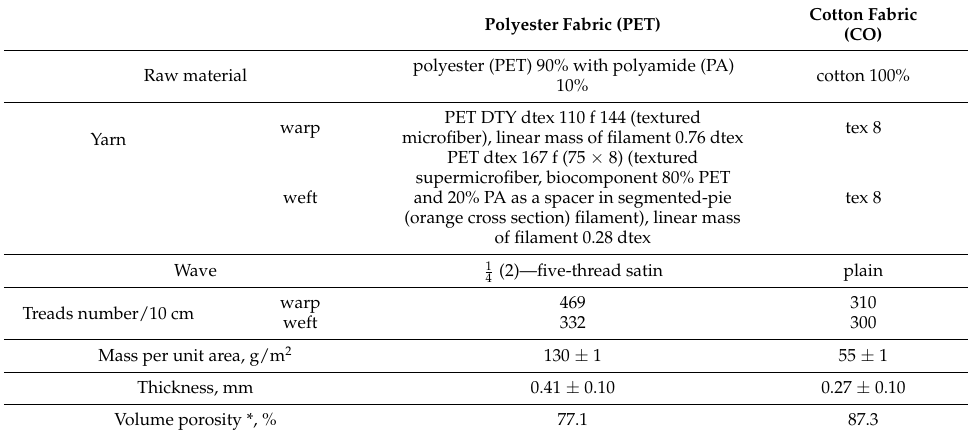
Table 1. Characteristics of textile materials.